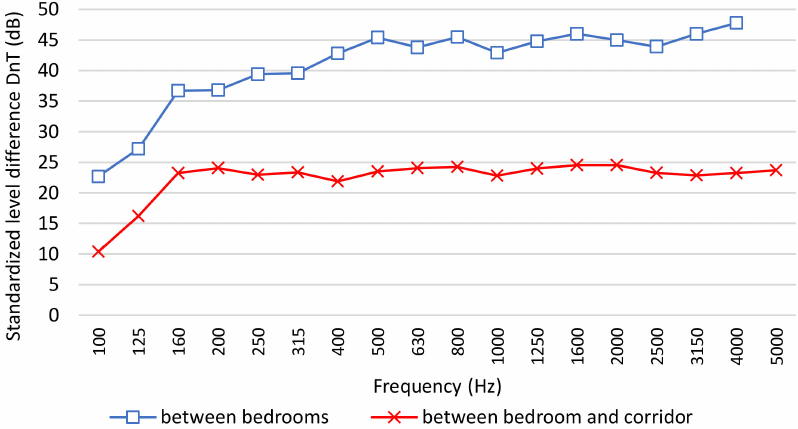
Figure 5. Standardized level difference, D nT , between the two bedrooms and between the corridor and the bedroom, with the doors closed (D nT,w between bedrooms = 44 dB; D nT,w between bedroom and corridor = 24